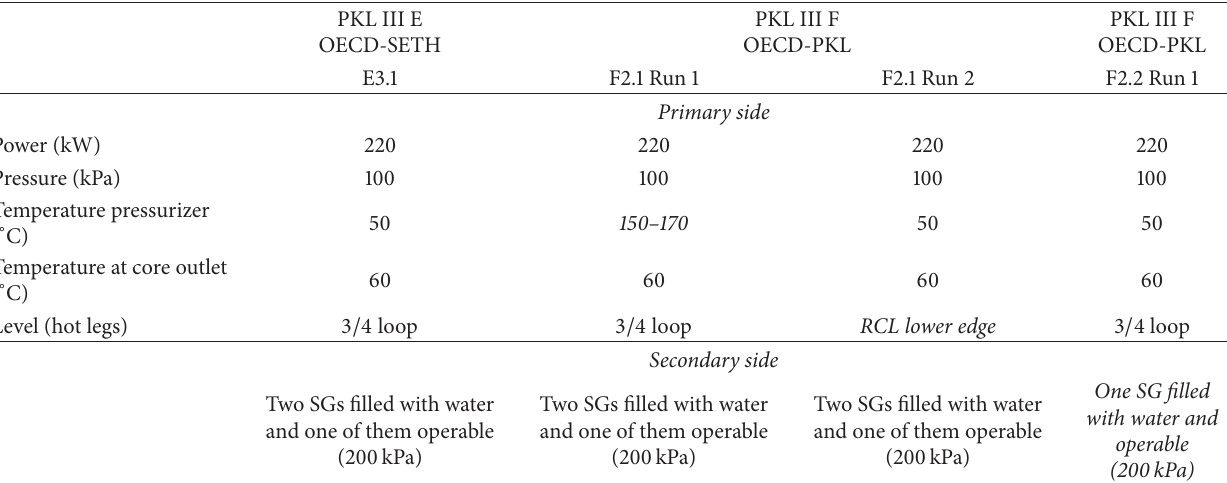
Table 1: E3.1, F2.1, and F2.2 initial conditions.